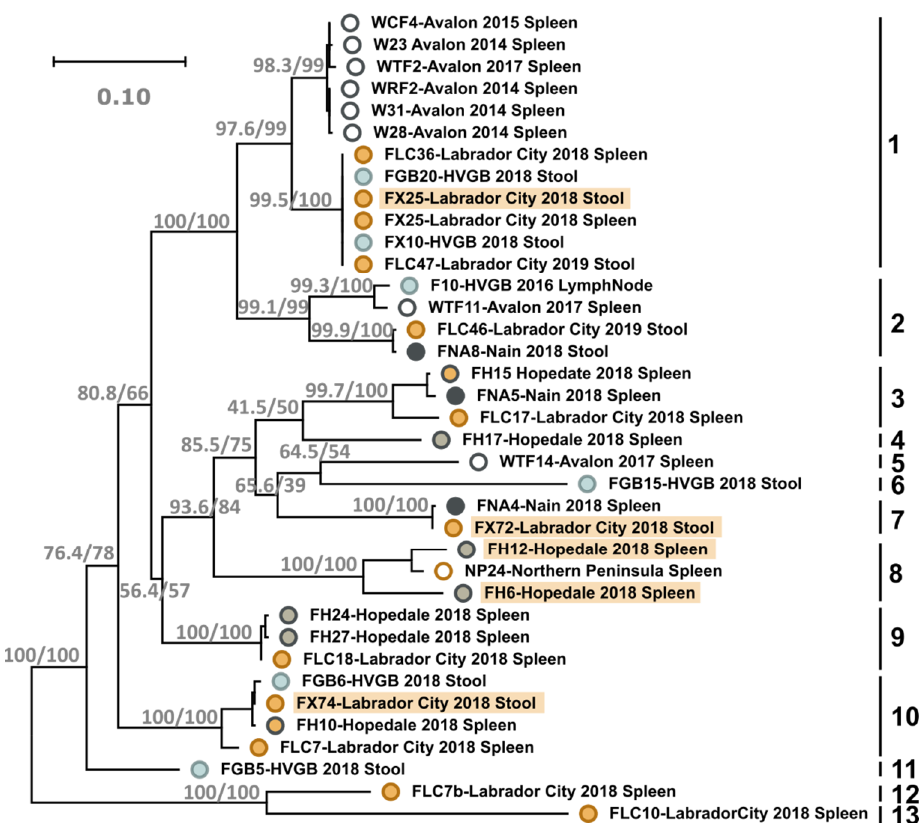
Figure 4 . Phylogenetic analysis of Newlavirus strains identified in this study. The unrooted phylogenetic tree is based on partial VP1 nucleotide sequences and was built with the maximum-likelihood method based on the GTR + F+I + G4 model with IQ-Tree. The outcomes of the SH-aLRT and bootstrap test (1000 replicates) are shown for the main nodes. The viruses identified in this study are labelled with colored circles corresponding to the sampling locations. Each sequence name includes the viral strain identifier, sampling collection site and type of sample in which the virus was identified. The 13 viral genotypes are indicated on the right and strains whose complete genomes were sequenced are highlighted in orange. HVGB: Happy Valley-Goose Bay.